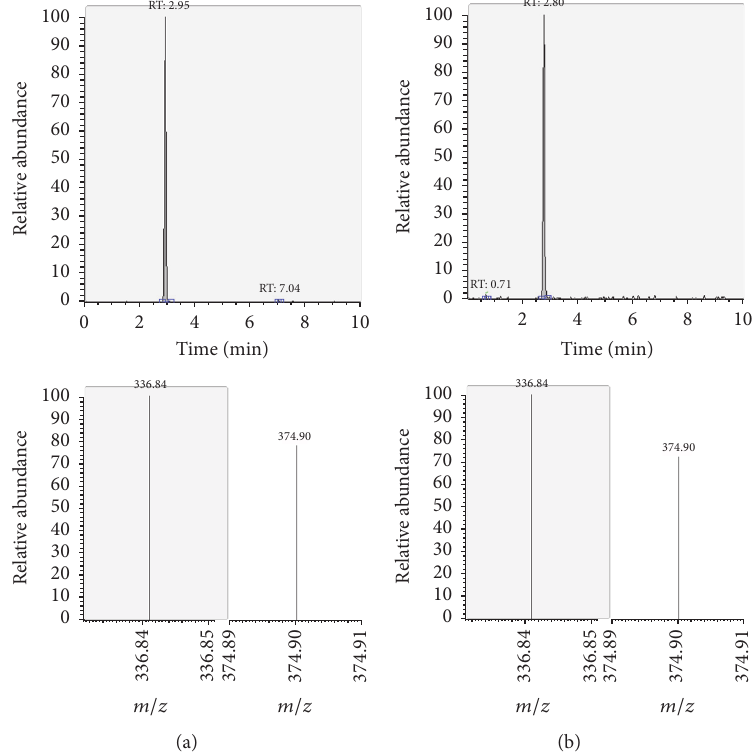
Figure 10: LC-MS/MS chromatograms of TRA and SRM transitions and relative abundances. (a) Standard in a 100 𝜇 g L −1 solution. (b) Standard in the spiked sample at 100mg kg −1 .